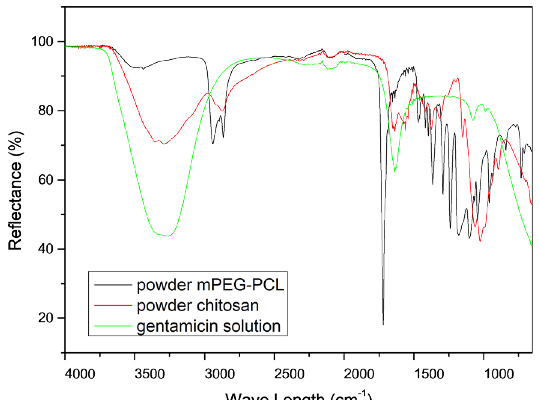
Figure 2. Infrared spectra of raw materials: (black) mPEG-PCL, (red) chitosan and (green) gentamicin